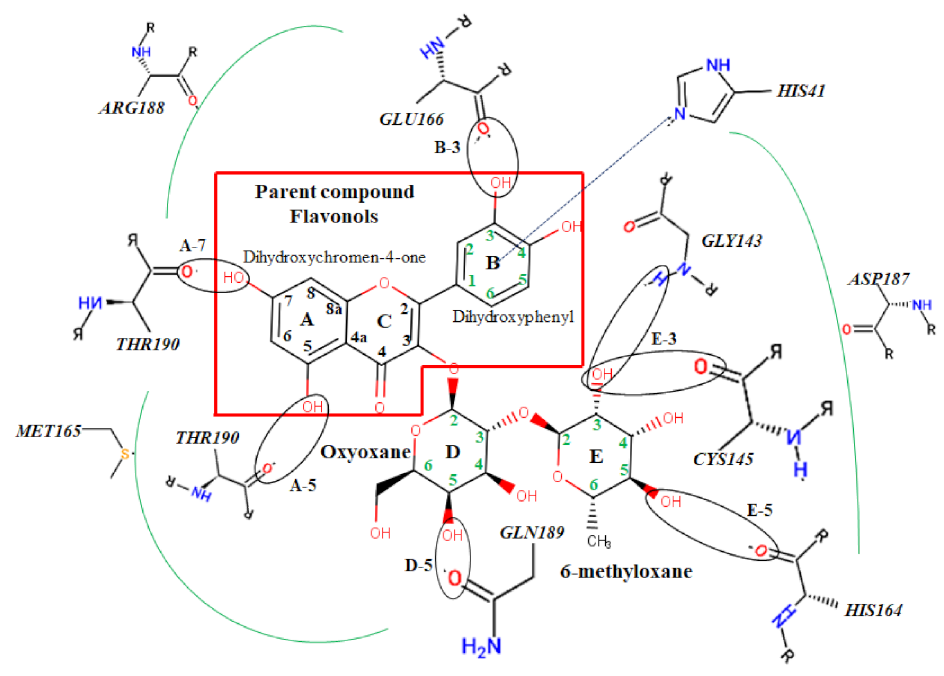
Figure 3. Atomic interaction of flavonoids with Mpro residues. While several residues form hydrophobic interactions with the ligands, other interactions such as hydrogen, π -cation, and π - π stacking were also involved in the inhibition mechanism of M pro .